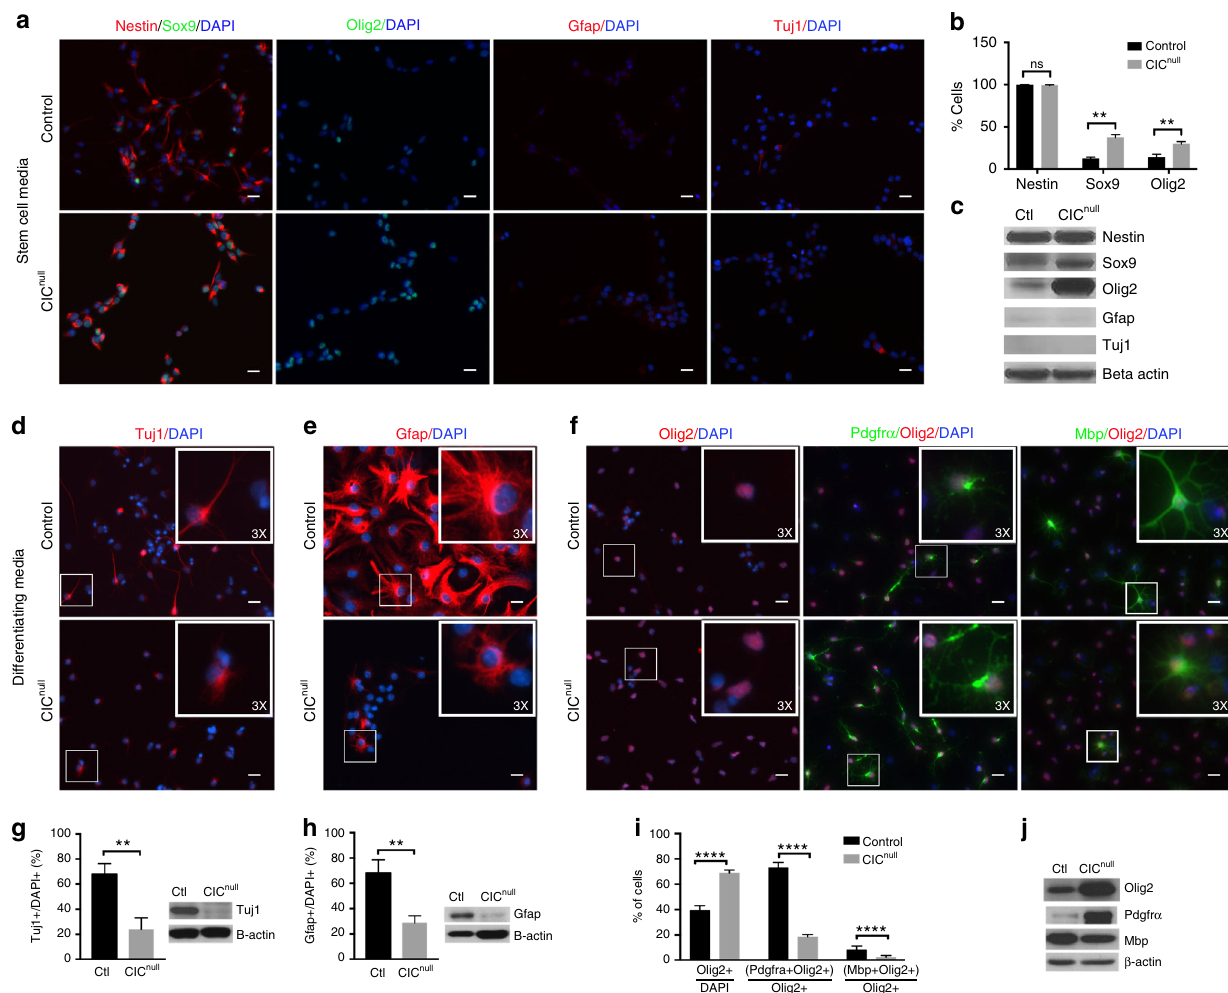
Fig. 5 Cultured Cic -null cells are oligodendrocyte lineage-biased. a – c Cic-null and control mouse NSCs, cultured in serum-free stem cell proliferation media and analyzed for expression of Nestin, Sox9, Olig2, Gfap, and bIII-Tubulin (Tuj1). Representative images of immuno fl uorescence staining a ; quantitation of cell percentages expressing Nestin, Sox9, and Olig2 b ; and western blots for Nestin, Sox9, Olig2, Gfap, and Tuj1, with b-Actin loading control c . d – j Responses of Cic-null and control NSCs to 10-day exposure to lineage-directed differentiation conditions for neurons, astrocytes, and oligodendrocytes. Representative staining and quantitation of Tuj1 + cells d , g in cultures exposed to neuronal-promoting conditions. Representative staining and quantitation of Gfap + cells e , h in cultures exposed to astrocyte-promoting conditions. Representative staining and quantitation of Olig2 + cells as a percentage all cells, Pdgfra + Olig2 + cells as a percentage of Olig2 + cells, and Mbp + Olig2 + cells as a percentage of Olig2 + clls f , i in cultures exposed to oligodendrocyte-promoting conditions, with western blotting j for Olig2, Pdgfra, and Mbp. Data from n = 3 biologic replicates per condition for all experiments. Source data are provided as a Source Data fi le. Statistical analysis performed by unpaired t test. Scale bar: 10 μ m. Data shown as mean ± SD. ns – not signi fi cant, ** p < 0.01, **** p <